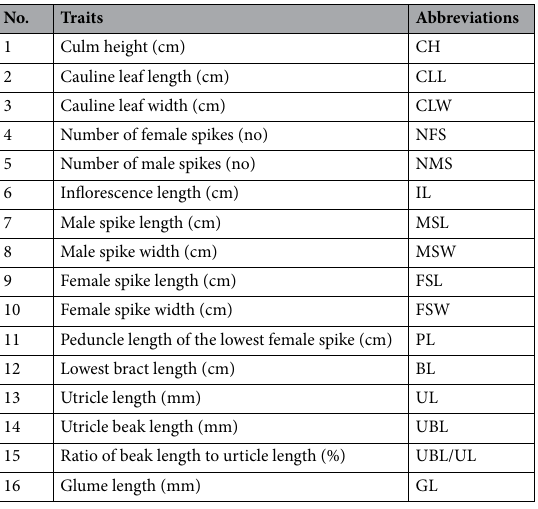
Table 1. Quantitative traits used in morphological